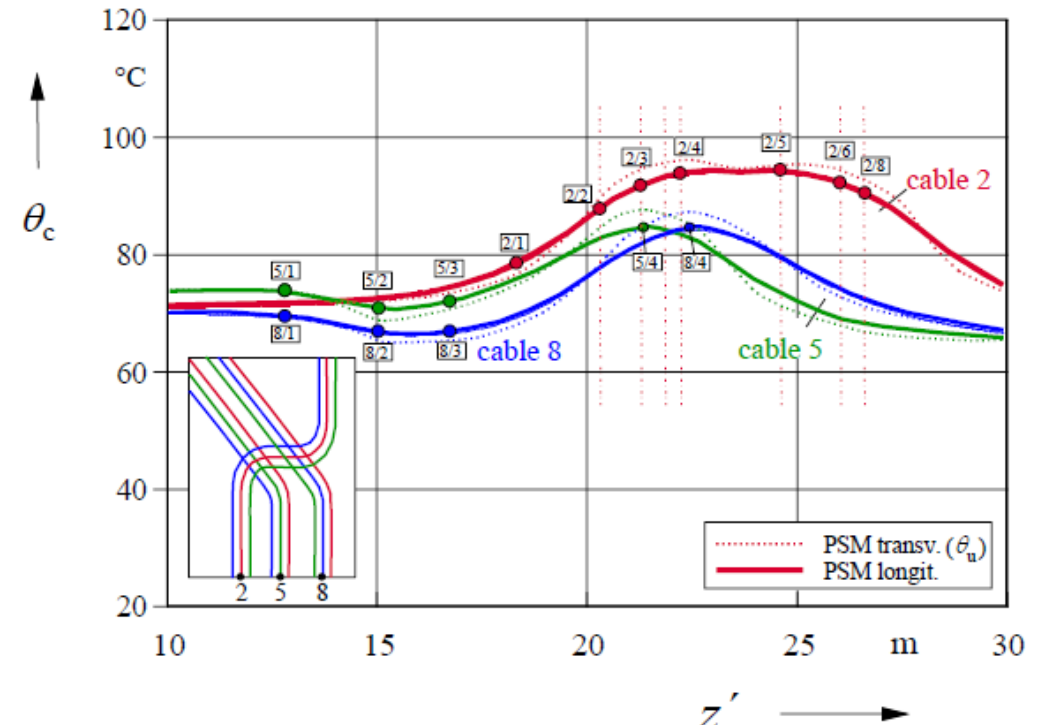
Figure 13. Distributions of the conductor temperatures of the middle cables 2, 5 and 8 in Figure 12 along the particular cable axes ( z ′ ); for explanations of the special points, see Figure 12 and Table 1. Abbreviations: transv. refers to the radial heat transfer only, whereas longit represents both radial and longitudinal heat flows.